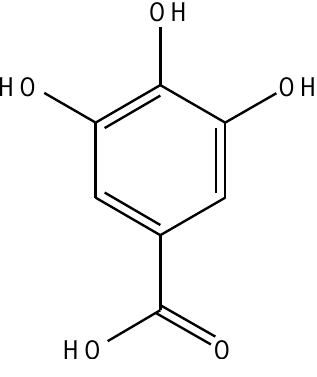
Figure 1. Structure of gallic acid.